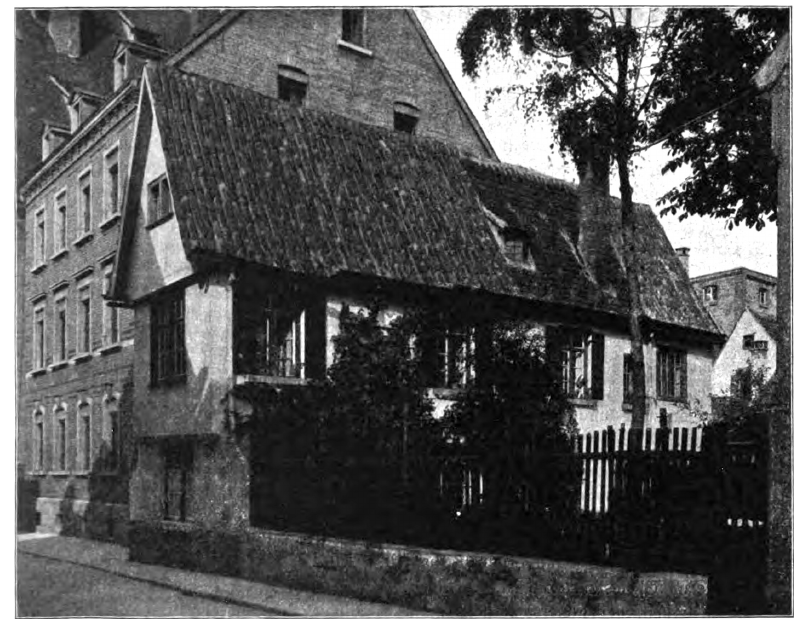
Figure 6. Comparison of an apartment complex and a row of Kleinhäuser . Source: Eberstadt (1910, p. 259). Urban Planning, 2022, Volume 7, Issue 1, Pages